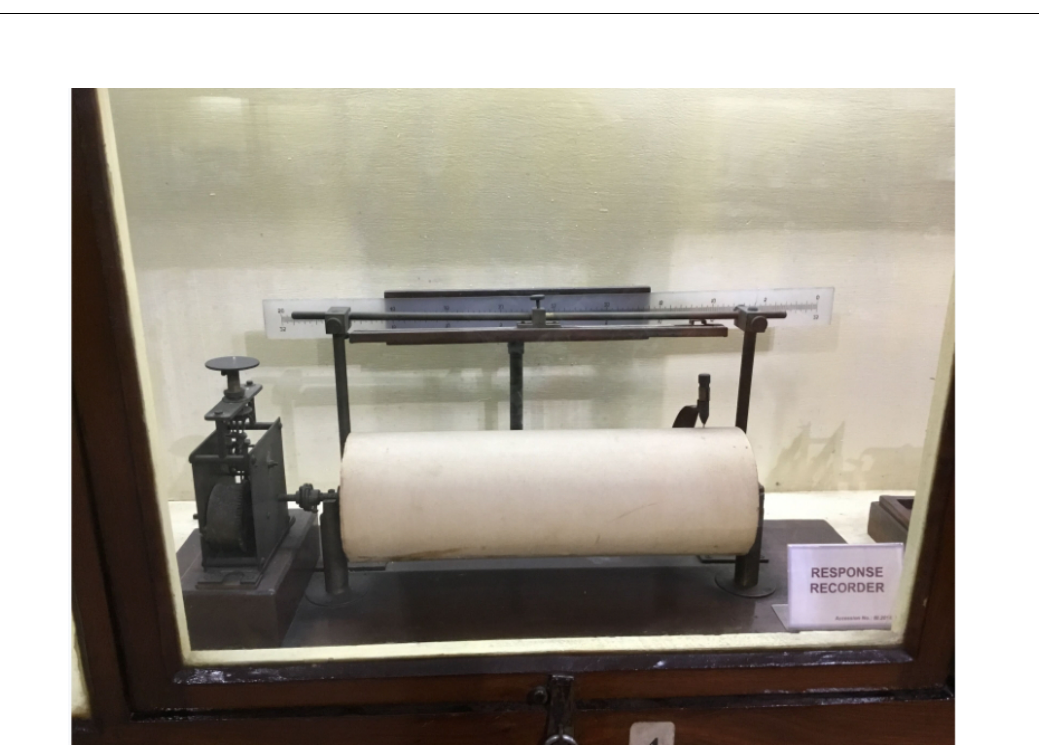
Figure 1b: Response recorder manufactured by J. C. Bose. Photographed by the author at the Bose Museum,